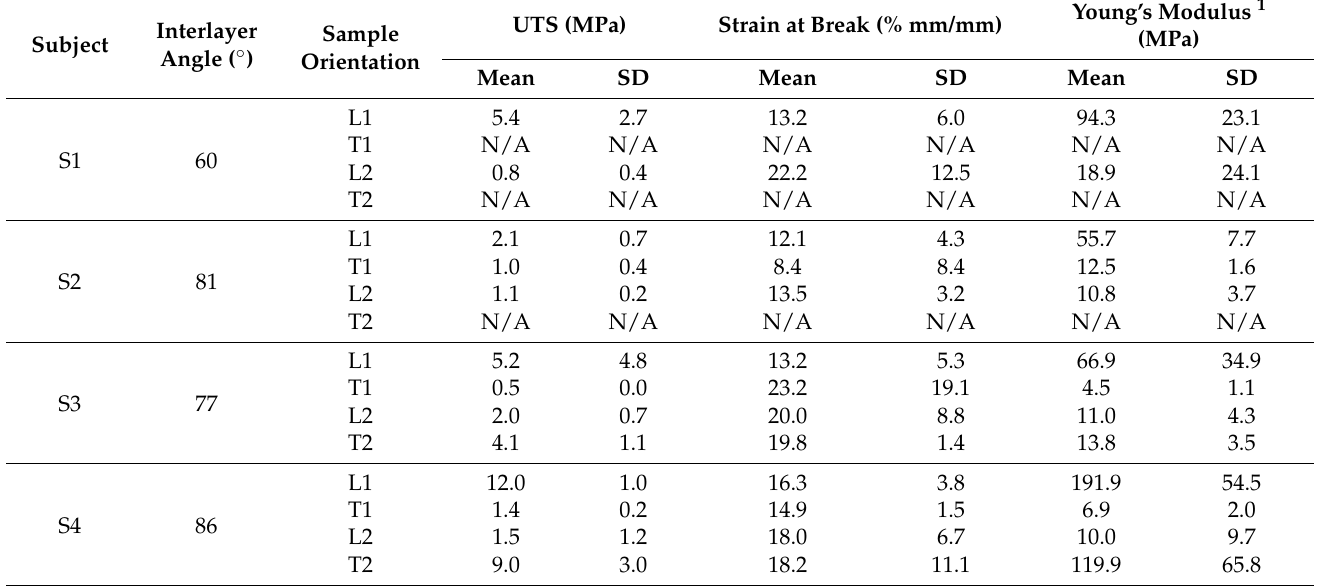
Table 1. Ultimate Tensile Strength (UTS), strain at break and Young’s Modulus of FL samples subjected to tensile tests up to failure. Mean and standard deviation (SD) for each subject and testing